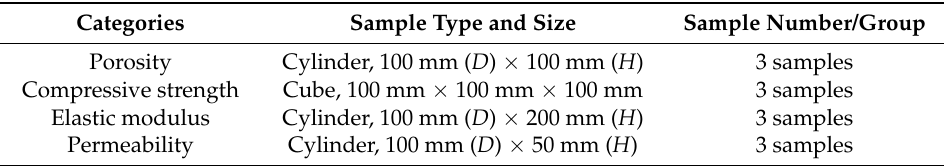
Table 4. Summary of concrete samples for the